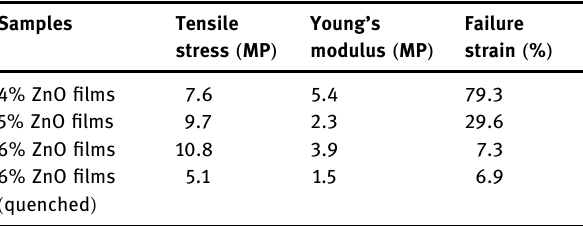
Table 3: Mechanical properties of passive cooling fi